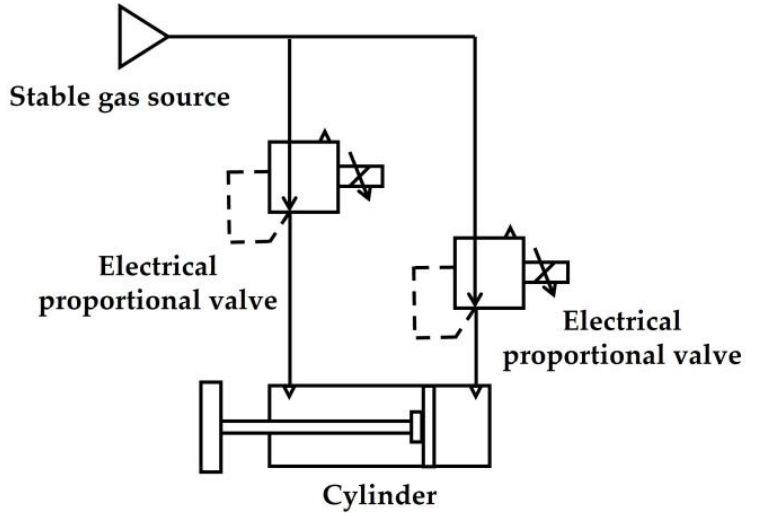
Figure 3. Air circuit design of force-controlled